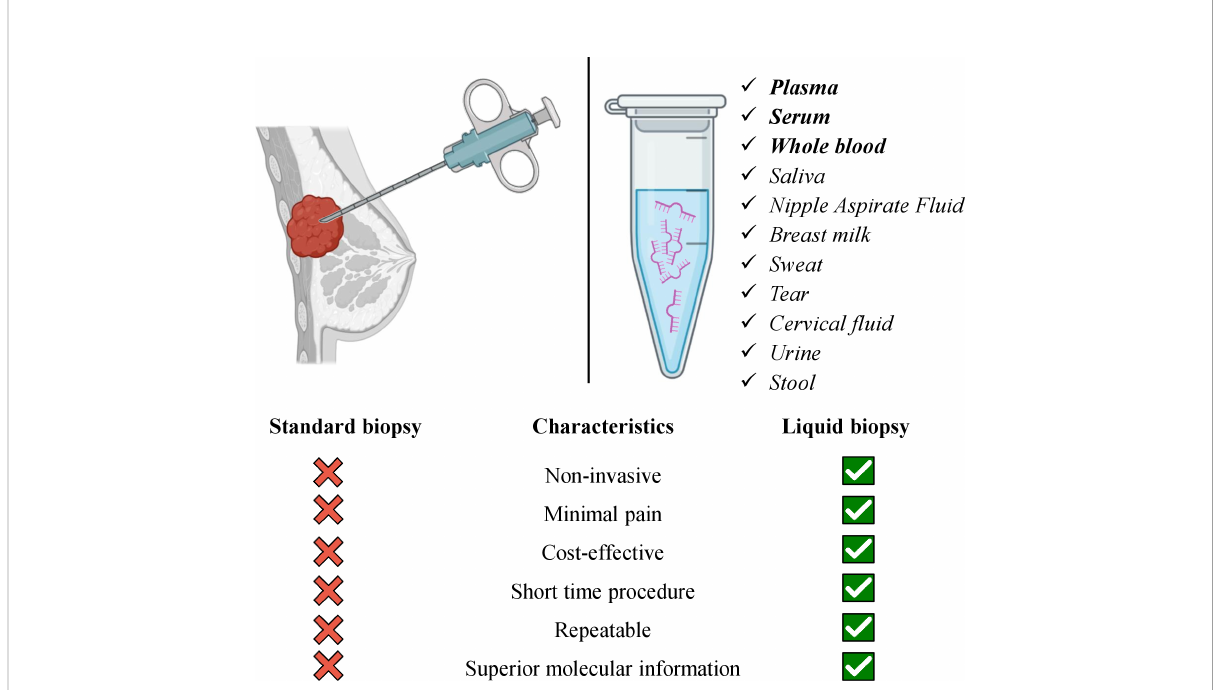
FIGURE 2 Advantages of liquid biopsy utility in breast cancer management via using various samples of body fl uids. The bio fl uids written in bold indicate the most studied samples for miRNA detection in breast cancer. Several listed bio fl uids have not yet been studied for miRNA detection as biomarkers in breast cancer, still, they represent potential liquid biopsy